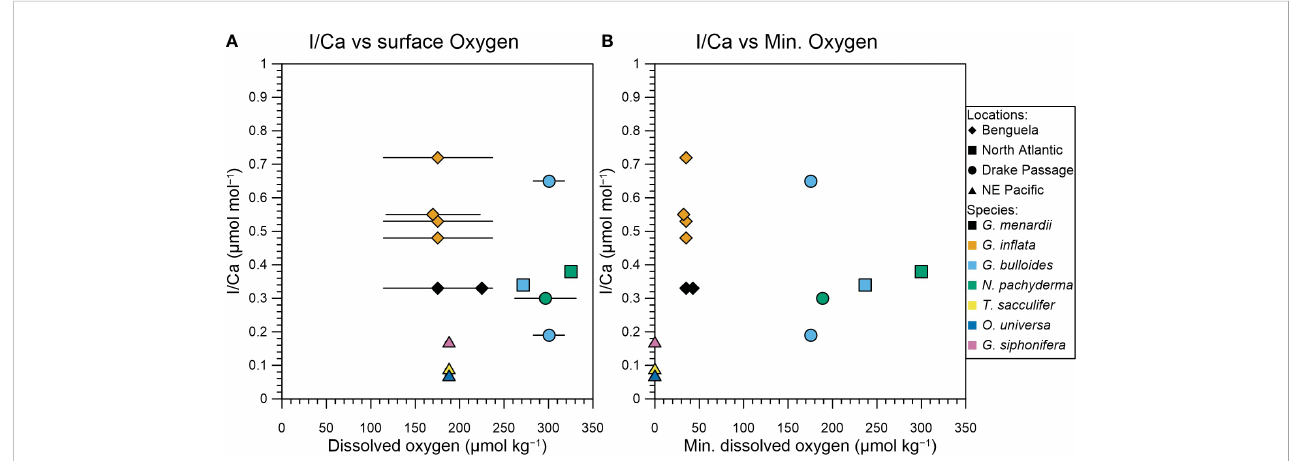
FIGURE 3 I/Ca values of planktic foraminifera compared to seawater oxygen concentrations. (A) planktic foraminifera I/Ca from net hauls vs. mean oxygen concentrations from the upper 120 m from nearby CTD casts. The range shows the maximum and minimum oxygen concentrations in the upper 120 m. (B) planktic foraminifera I/Ca vs. the minimum water column oxygen concentration, generally deeper down in the water column.